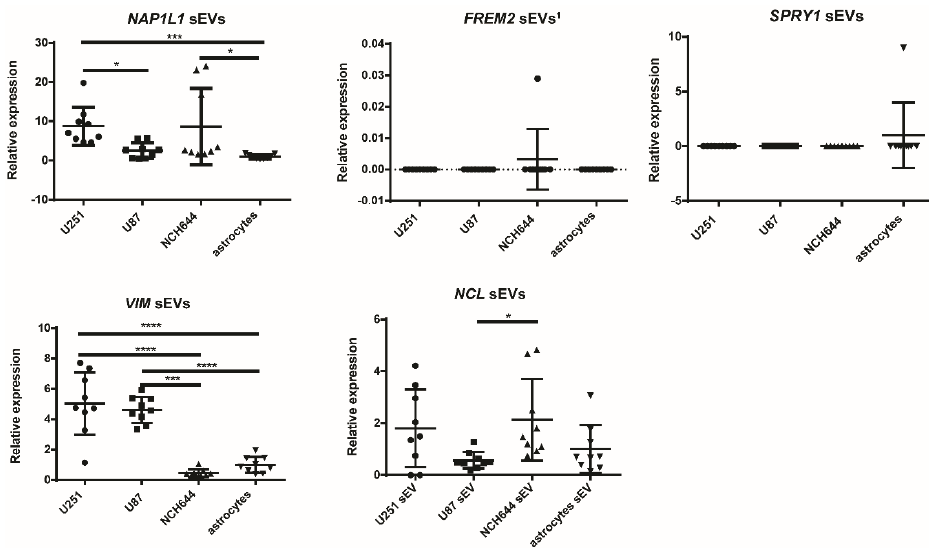
Figure 6. Relative mRNA expression in GBM and normal astrocyte sEVs. Results are presented as mean, and error bars represent standard deviation. * p < 0.05, *** p < 0.001, and **** p < 0.0001. FREM2 sEVs 1 —data normalized to reference gene are not presented, as the expression of FREM2 in sEVs of astrocytes was under the detection threshold. GBM—glioblastoma. sEVs—small extracellular